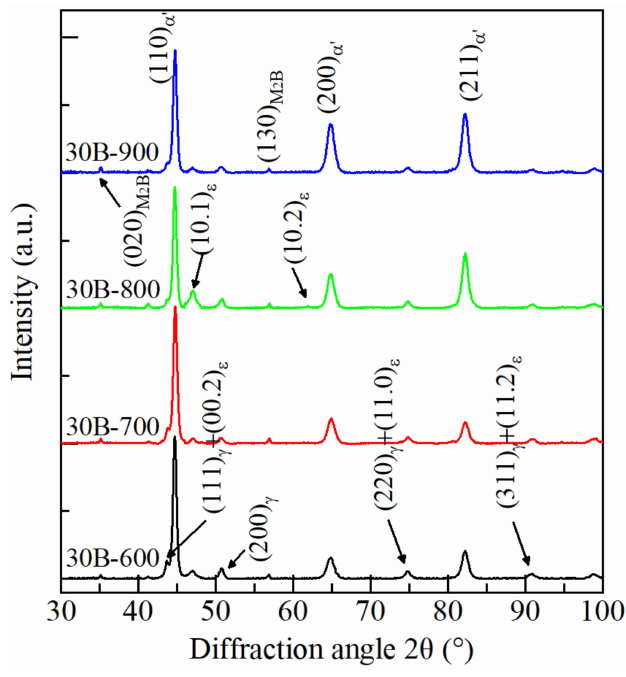
Figure 10. XRD patterns of the fractured 30B samples. Table 5. Calculated phase fraction (%) in 30B steel samples after tensile test according to XRD.